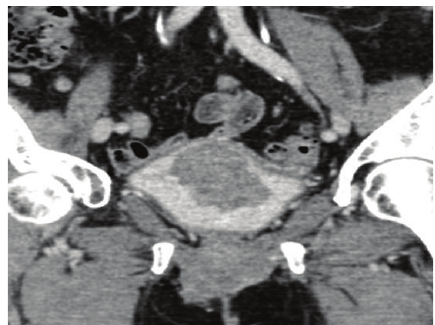
Figure 6: CT of kidneys (coronal nephrographic phase image) demonstrates an enhancing mass lesion arising from the lower pole oftheleftkidneyconsistentwithahistologicallyconfirmedrenalcell carcinoma.